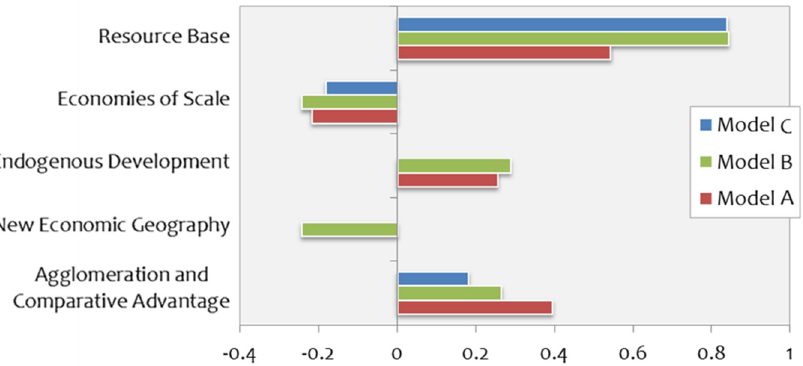
Figure 8. Clustered bar charts of the standardized BEM linear regression coefficients.